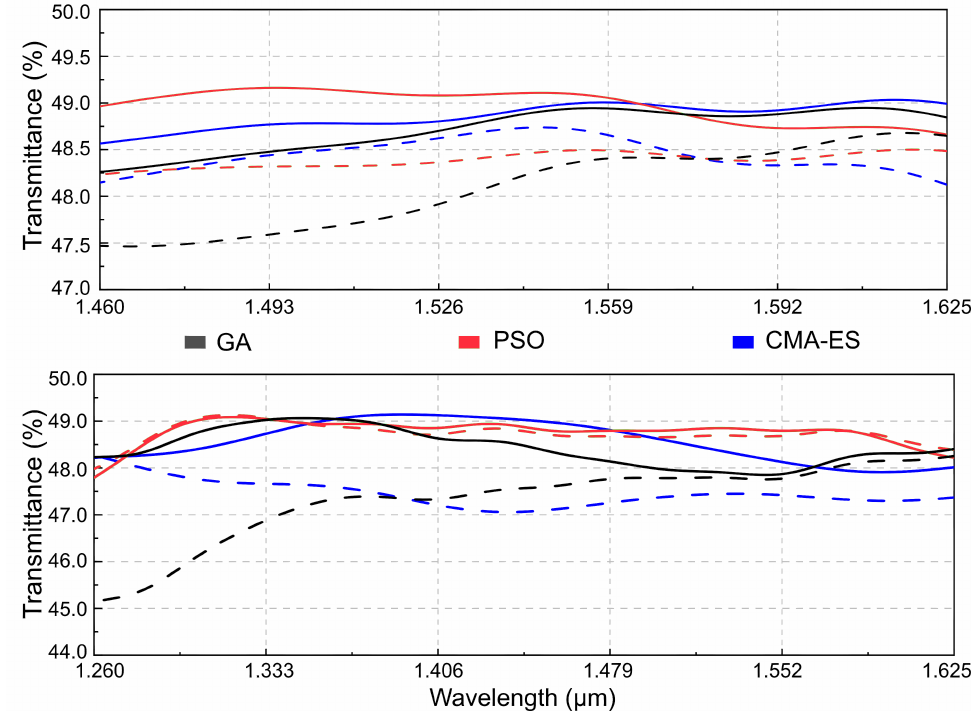
Figure 6. Waveband analysis of the best (solid lines) and the worst (dashed lines) executions for each algorithm. ( Top ) SCL-band and ( Bottom ) OESCL-band.